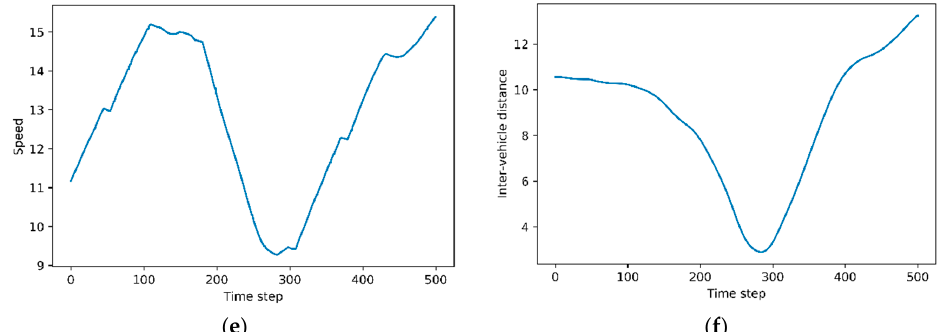
Figure 7. Evaluation results: ( a ) speed profile of the host vehicle in all episodes; ( b ) inter-vehicle distance in all episodes; ( c ) speed profile of the host vehicle in the highest cumulative reward; ( d ) inter-vehicle distance in the highest cumulative reward; ( e ) speed profile of the host vehicle in the lowest cumulative reward; ( f ) inter-vehicle distance in the lowest cumulative reward.